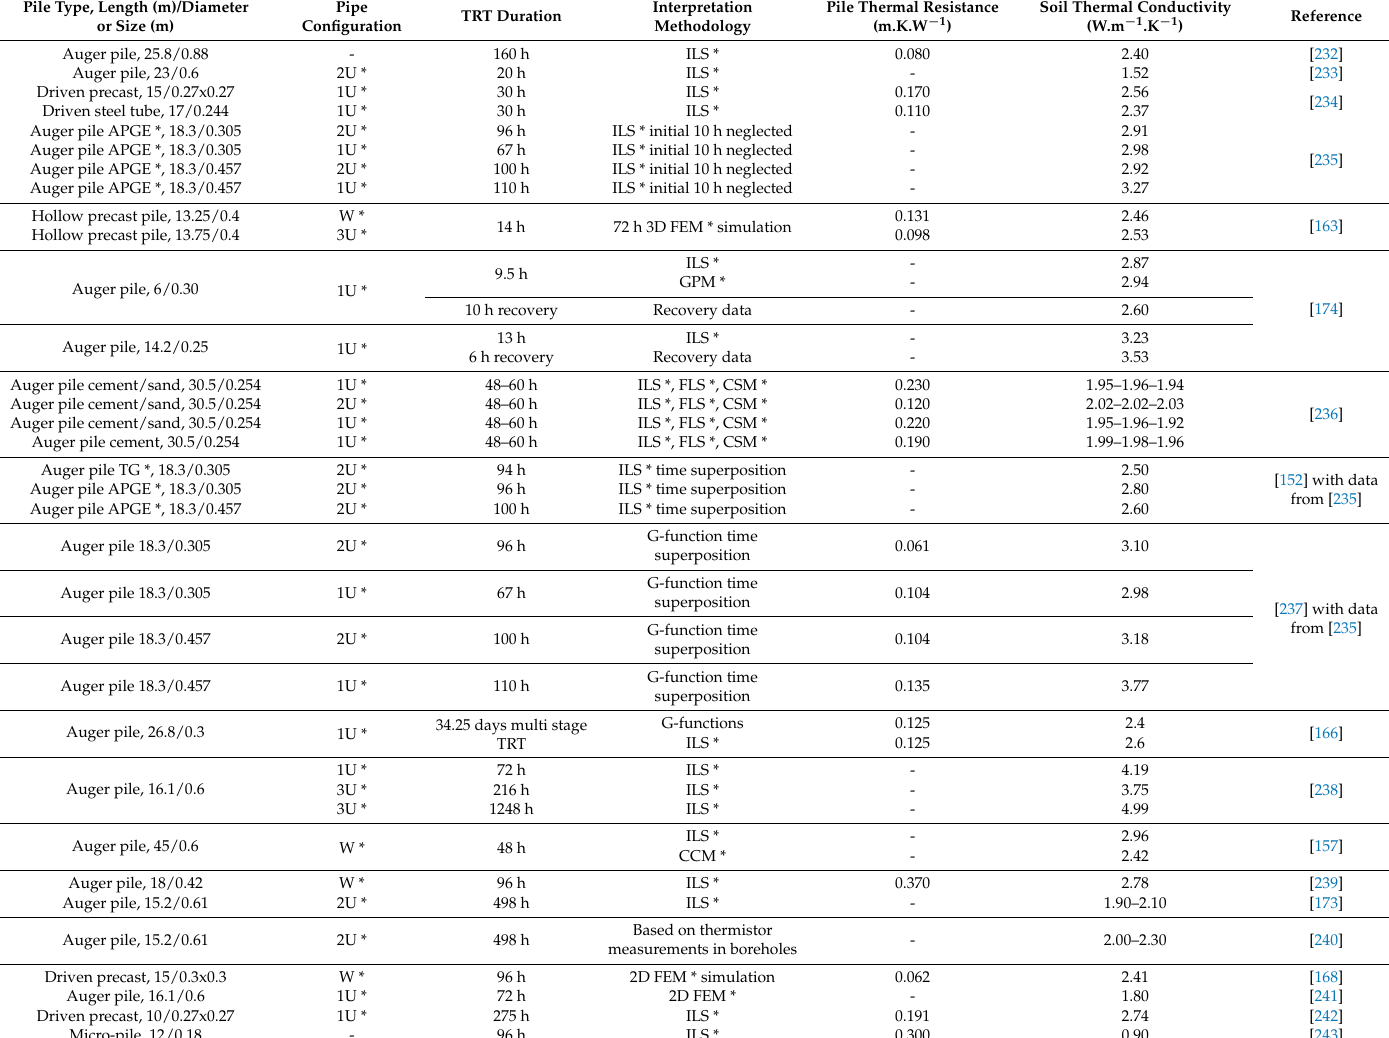
Table A2. Summary of studies where thermal response testing of pile heat exchangers has been adopted to obtain the thermal conductivity of the soil. Pile Type, Length (m)/Diameter or Size